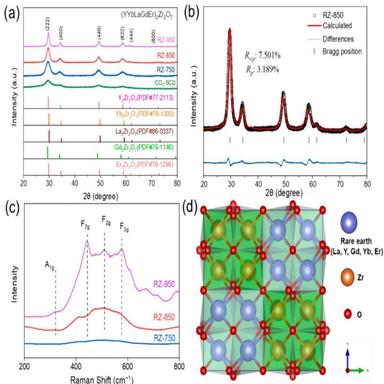
(a) XRD pattens of samples and the standard X-ray diffractograms (RE = Y, Yb, La, Er, Gd), (b) the Rietveld refinement of the XRD spectra, (c) the Raman spectra of the RZ samples, (d) crystal model of (YErYbGdLa)2Zr2O7 ceramic aerogel.